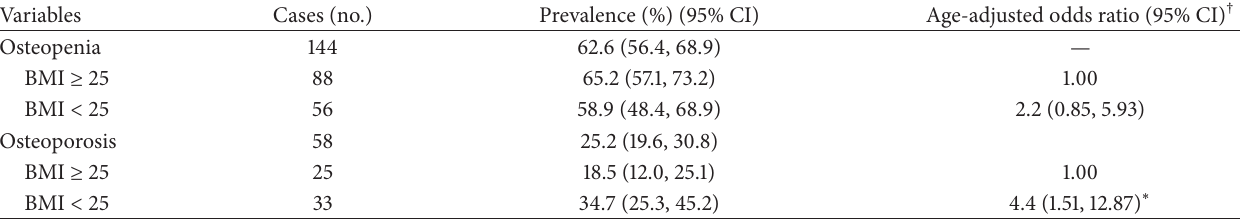
Table 3: Prevalence rates and odds ratio (95% CI) of osteopenia and osteoporosis by body mass index status.